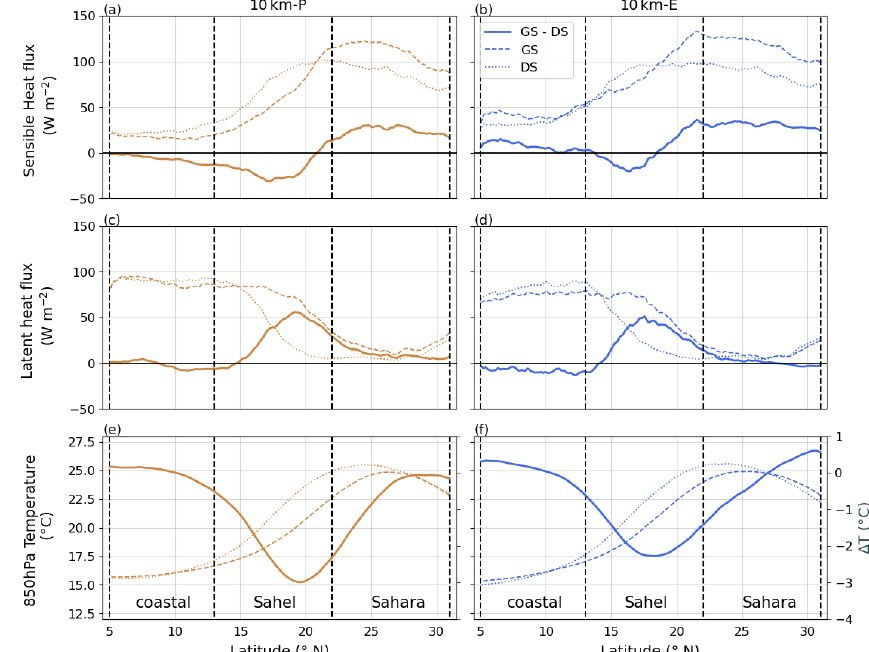
Figure B1. JAS mean meridional distribution of sensible heat flux (a, b) , latent heat flux (c, d) , and 850hPa temperature (e, f) for the Desert Sahara simulations (blue dotted lines), the Green Sahara simulations (blue dashed lines), and the difference between Green Sahara and Desert Sahara simulation (blue solid lines) for the 10km-P (a, c, e) and the 10km-E (b, d, f) simulation, respectively. The vertical dashed lines indicate the boarders of the coastal, the Sahel, and the Sahara region outlined in Fig.